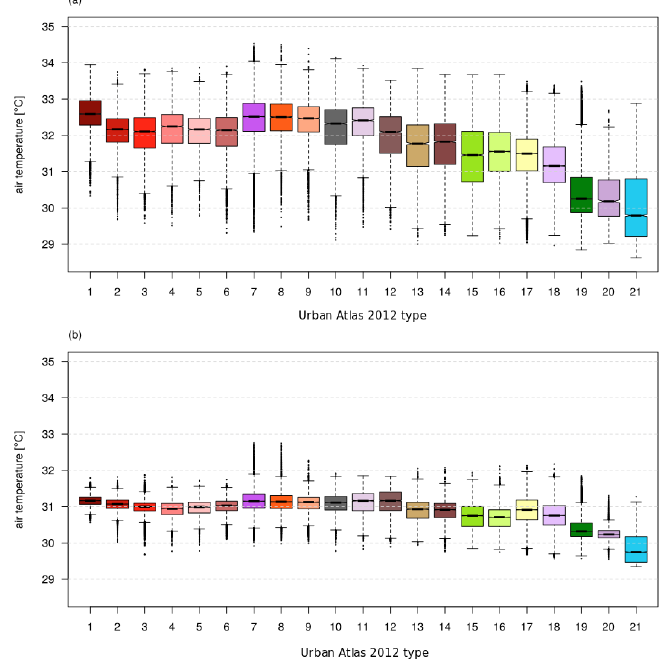
Figure 8. Statistic of air temperature in Pozna ń (( a )—12 July 2010, ( b )—11 August 2015) on the basis of Landsat images according to Urban Atlas 2012 types (colours and order of types according to legend in Figure 1). In the boxplot, the middle values denote medians; the box extends to the Q1 (first quartile) and Q3 (third quartile), while the whiskers show the range (99.3%). The upper whisker shows Q3 + 1.5 × IQR (the interquartile range) and the lower shows Q1 − 1.5 × IQR. The notches extend to +/ − 1.58 IQR/sqrt(n) and the dots represent outliers.